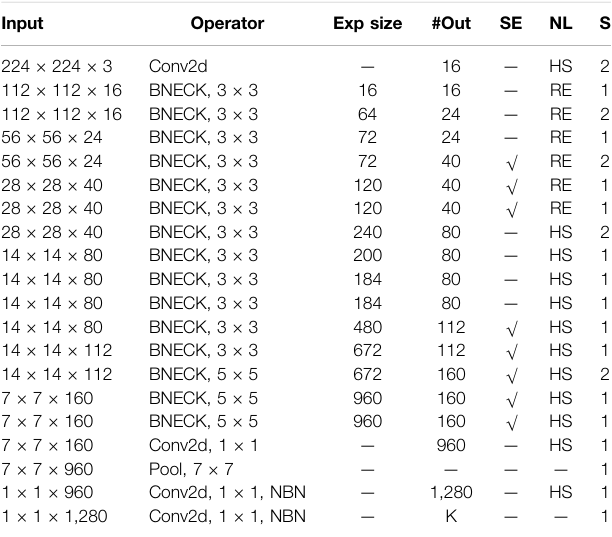
TABLE 2 | Structure of